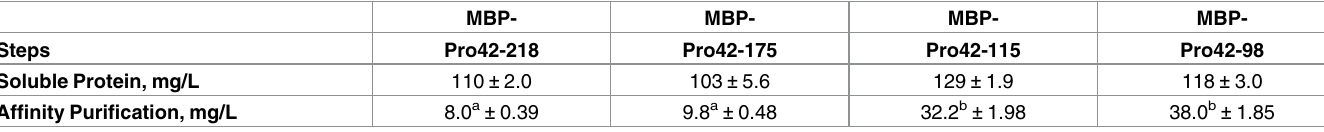
Soluble Protein, mg/L Affinity Purification,